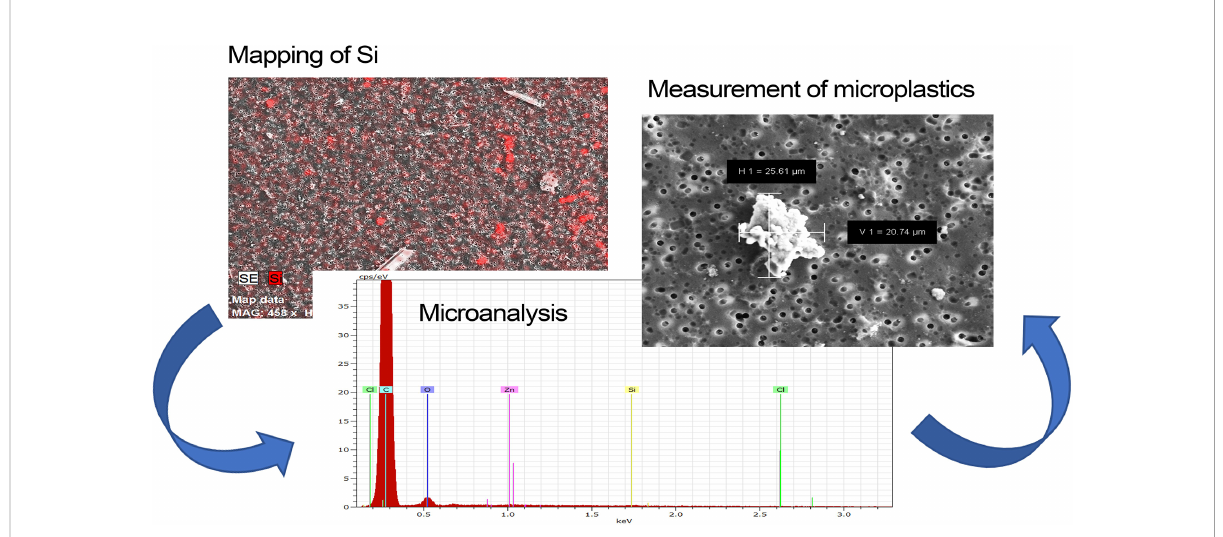
FIGURE 2 Work fl ow of microplastic identi fi cation by Scanning Electron Microscopy (SEM). Reported are the silicon EDX map (Mapping of Si), which is used to distinguish the sediment grains from the other inorganic particles, and the EDX microanalysis (i.e., Microanalysis) of the Si-free inorganic particles (i.e., Measurement of microplastics) used to verify the large presence of C, which is the speci fi c element of the microplastics (H cannot be detected by